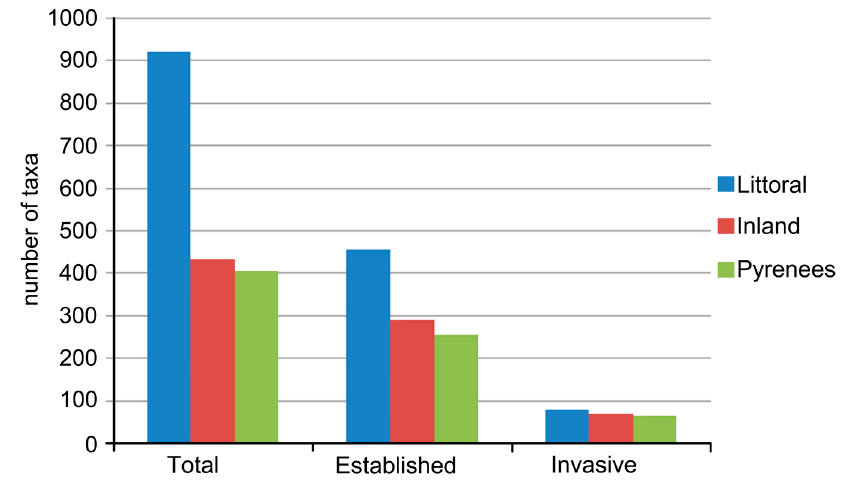
Figure 2. Number of alien taxa (total, established and invasive) in the geographical regions recognized in this study (Littoral, Inland and